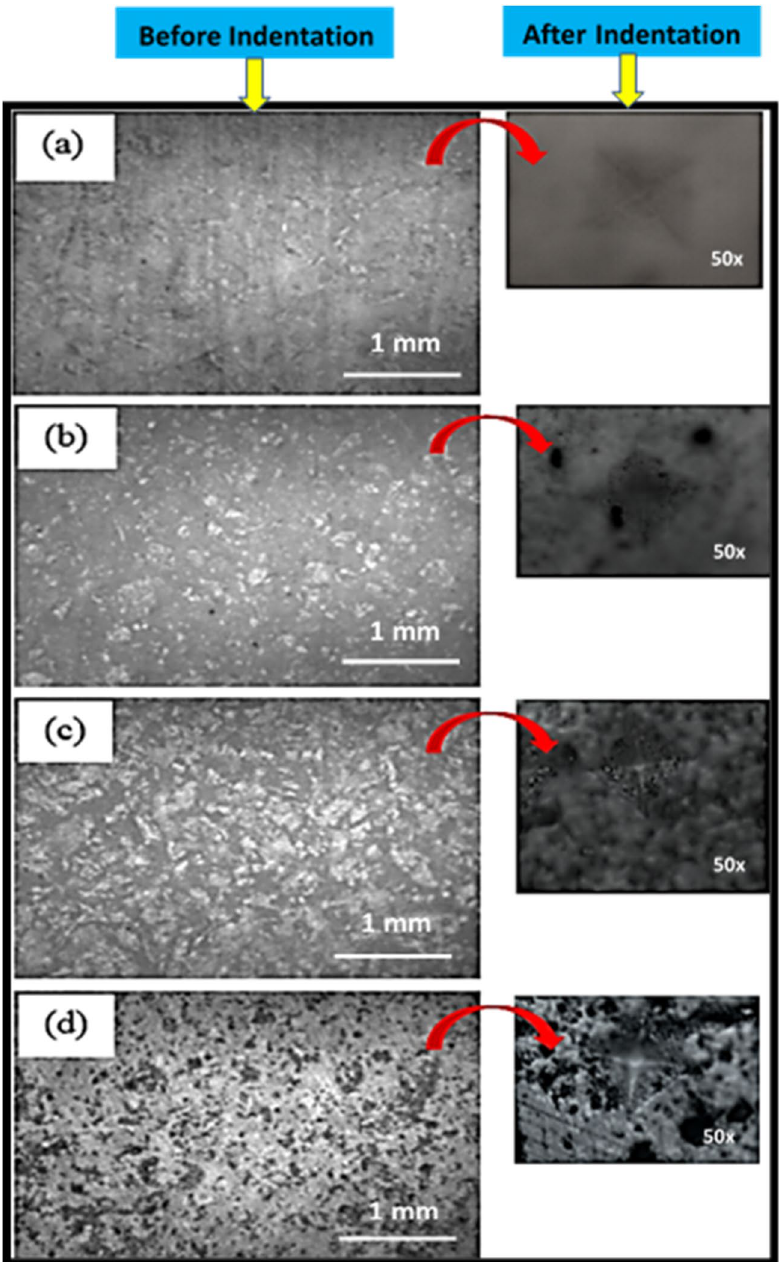
Figure 8. ( a – d ) Microscopic images of S0, S1.0, S2.0, and S3.0